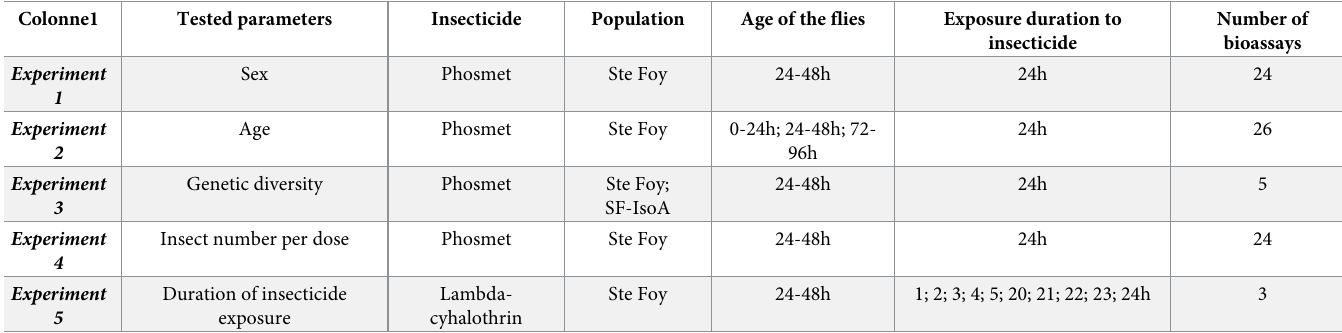
Table 1. Parameters tested in the five